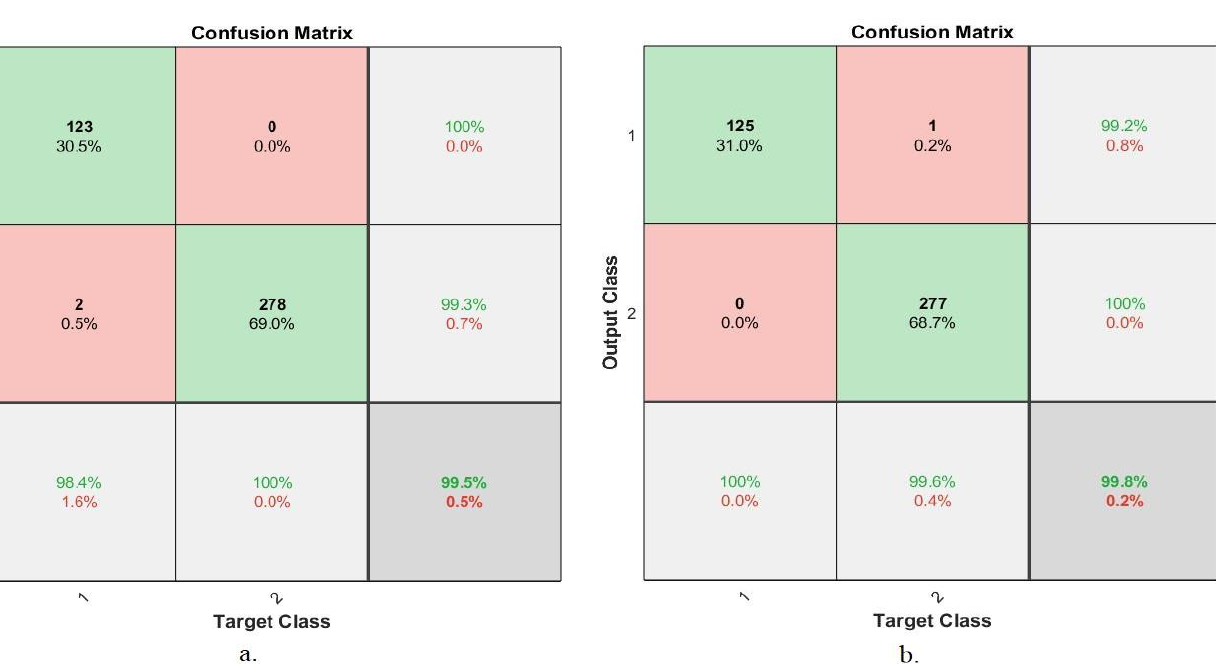
Figure 12. Confusion matrix for ANN for classifying a 100× dataset based on fusion features by ( a ) AlexNet with FCH, LBP, and GLCM and by ( b ) GoogLeNet with FCH, LBP, and GLCM.